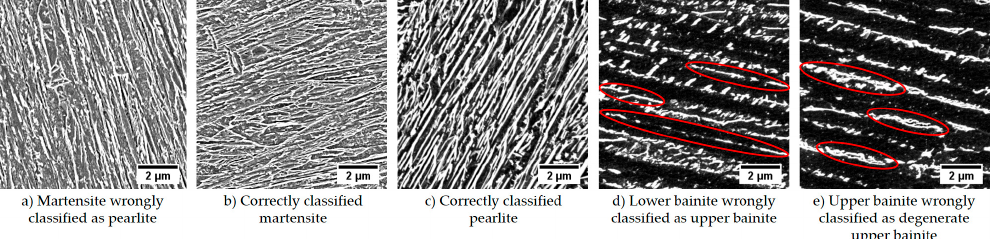
Figure 13. Examples of misclassified pictures: ( a ) wrongly martensite showing a regular lath structure compared to the more irregular laths of correctly classified martensite ( b ) and similar to pearlite ( c ), ( d ) lower bainite with some slender cementite precipitation on the lath boundaries (red), similar to upper bainite, and ( e ) upper bainite with some cementite aggregates, similar to degenerated upper bainite.